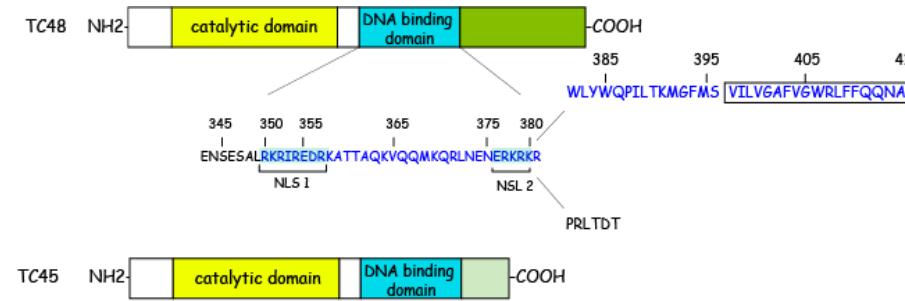
Figure 1. Structure of 45 kD and 48 kD PTPN2 variants. This image indicates the catalytic and non-catalytic C-terminal domains of PTPN2. Its catalytic domain highlights the high degree of primary sequence conservation. The DNA binding domain contains two basic clusters (residues 350–358 (RKRIREDRK) and 377–381 (RKRKR)) that form a bipartite nuclear localization signal (NLS). TC45 localizes to the nucleus by virtue of NLS. The hydrophobic C-terminal tail of TC48 must override the bipartite NLS to permit the targeting of the ER. The region shown in blue (from 350–415) is where sites in TC48 interact with p23 and p25.